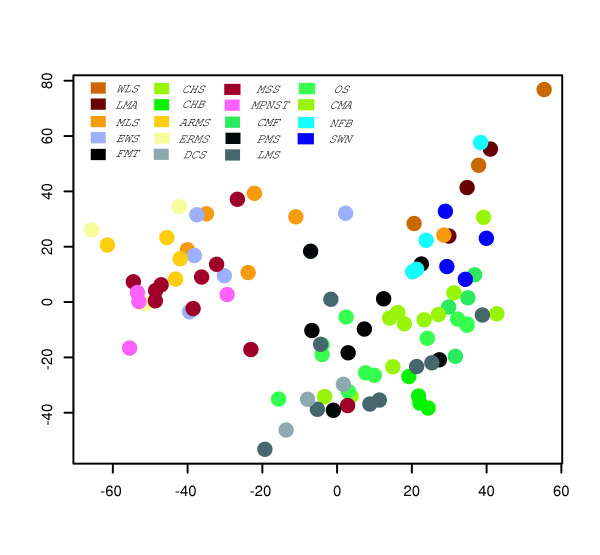
Multi-dimensional scaling of all 96 mesenchymal tumor samples. There are 19 types of tumor shown; the color coding of which is used consistently for all figures. All gene expression values were used to calculate the inter-sample Euclidean distance matrix. The distances are translated here onto a two-dimensional plane using the classical cmd-scale algorithm of R. The stress of the plot was 0.34; an index of the goodness of fit between the original distance matrix and the MDS distance (see Materials and methods). WLS, well-differentiated liposarcoma; LMA, lipoma; MLS, myxoid liposarcoma; EWS, Ewing's sarcoma; FMT, desmoid fibromatosis; CHS, chondrosarcoma; CHB, chondroblastoma; ARMS, alveolar rhabdomyosarcoma; ERMS, embryonal rhabdomyosarcoma; DCS, de-differentiated chondrosarcoma; MSS, monophasic synovial sarcoma; MPNST, malignant peripheral nerve sheath tumors; CMF, chondromyxoid fibroma; PMS, pleomorphic sarcoma; LMS, leiomyosarcoma; OS, osteosarcoma; CMA, chordoma; NFB, neurofibroma; SWN, schwannoma.